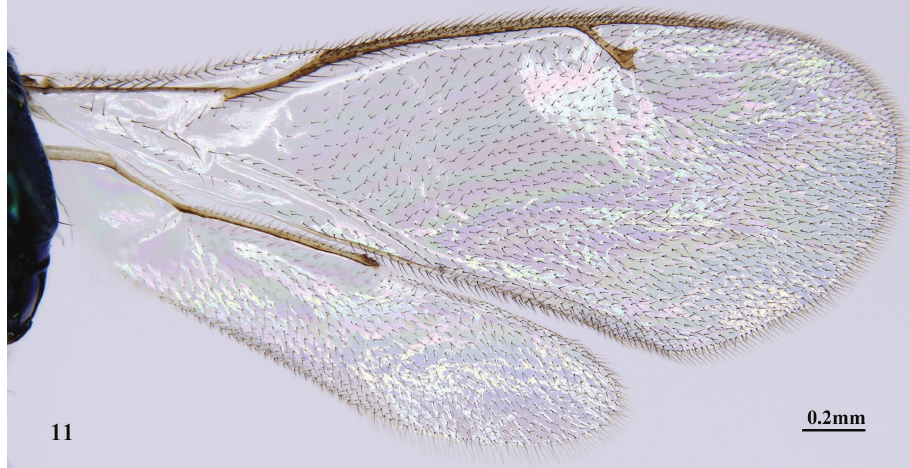
Figure 11. Pnigalio eriocraniae Li & Yang, sp. n., female, holotype,